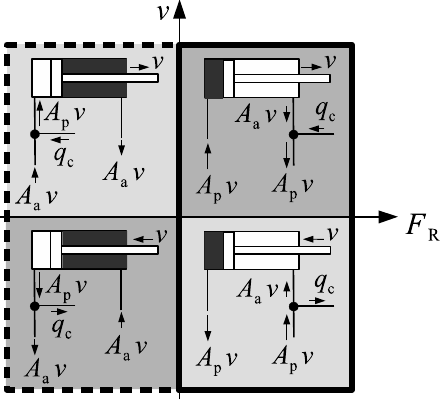
Figure 29. Expected circuit flows at each quadrant of operation. Pumping quadrants are shown in darker grey and motoring quadrants are shown in lighter grey.